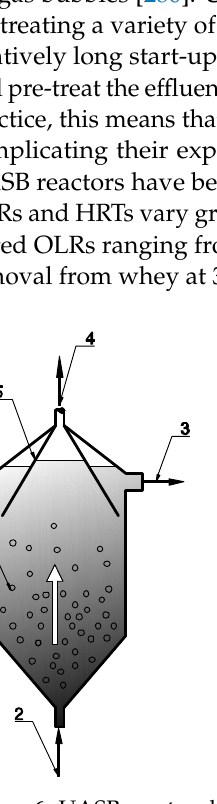
Figure 6. UASB reactor diagram: 1—granules, 2—raw wastewater, 3—treated effluent, 4—biogas, 5—three ‐ phase separator.